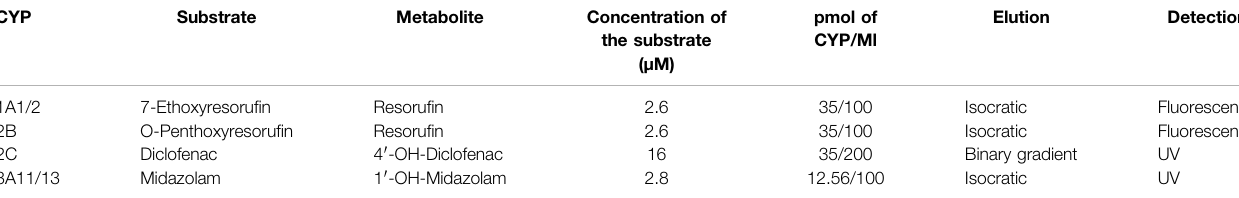
TABLE 2 | Conditions and HPLC parameters for cytochrome P450 enzyme activity